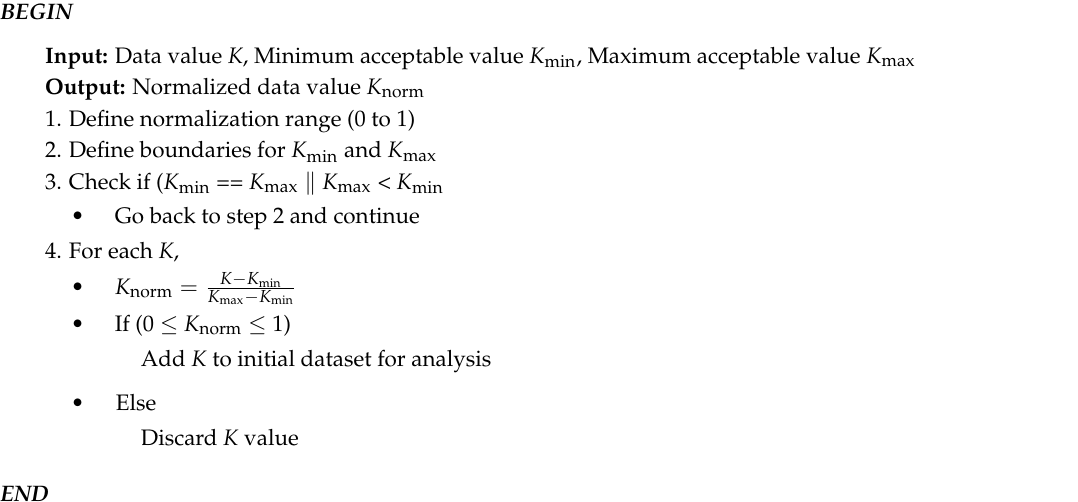
Algorithm 1 Data Normalization with Min-Max